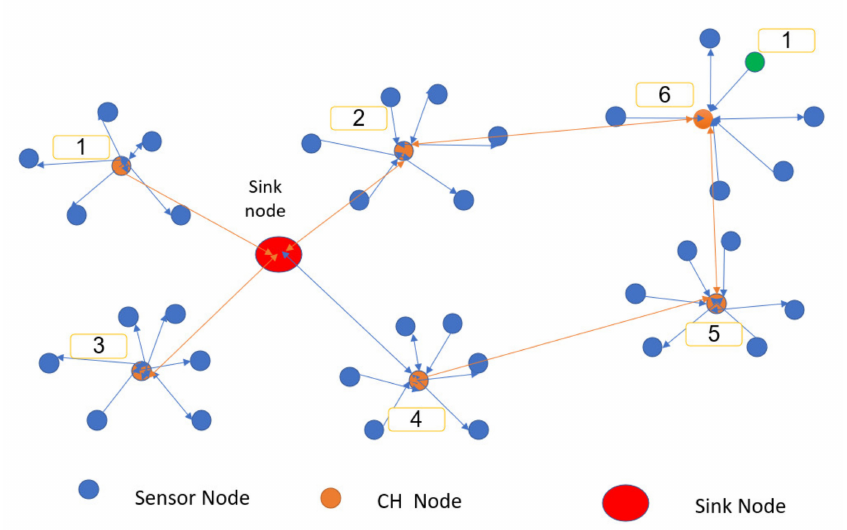
Figure 5. Typical routing